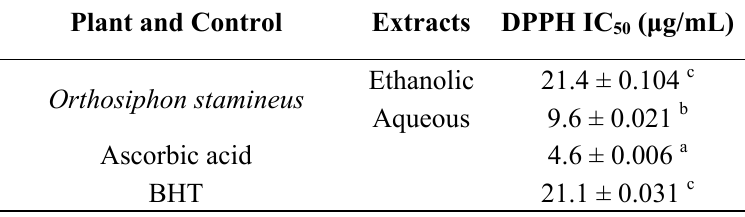
Table 3. Free radical scavenging activity (DPPH) of the investigated